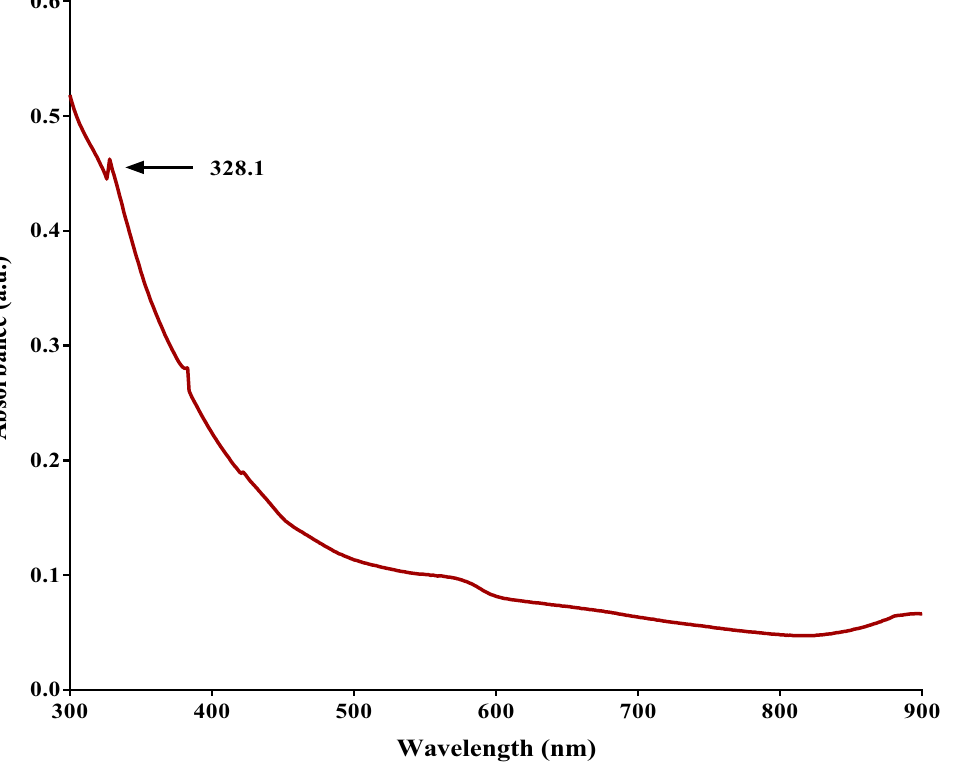
Figure 2. UV-V is Spectroscopy of Fe 2 O 3 Nanoparticles synthesized from Bauhinia tomentosa leaf extract using the FeCl 3 solution. The characteristic peak formed at 328 nm shows the formation of